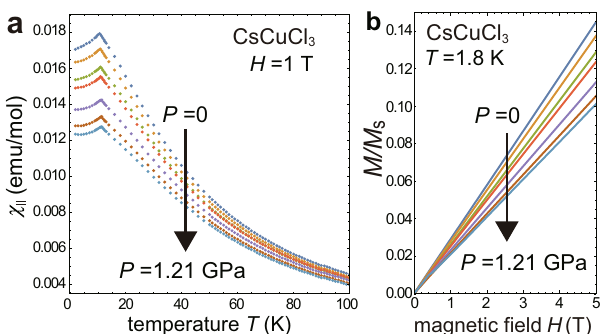
Fig. 4 Magnetic susceptibility and magnetization curves under pressure. a Longitudinal susceptibilities χ ∥ at H = 1 T and b magnetization curves at T = 1.8 K for a CsCuCl P = 0, 0.14, 0.34, 3 crystal under different pressures, 0.49, 0.82, 1.05, 1.21 GPa (from top to bottom) when a magnetic fi eld is applied along the c axis. The magnetization M is scaled by the saturation value M s .